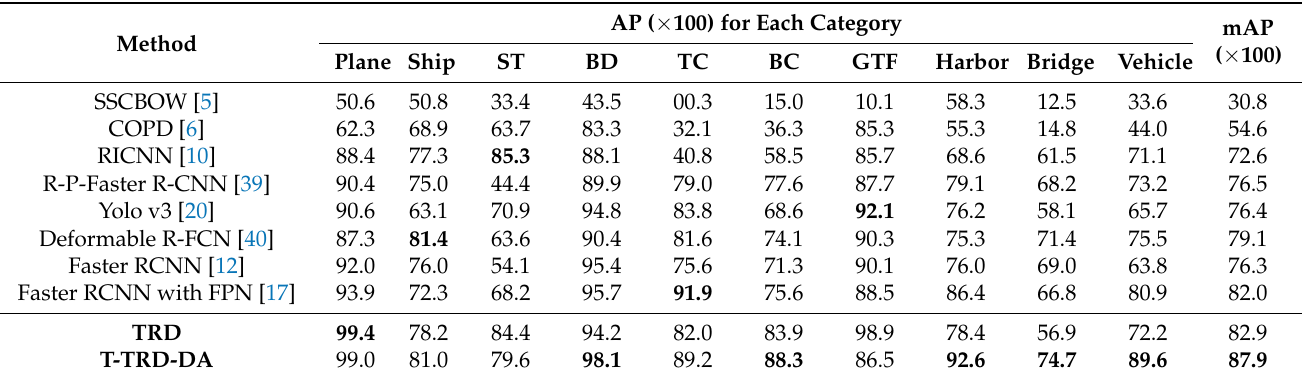
Table 1. Comparison results of the proposed methods and baseline methods on the NWPU VHR-10 data set.